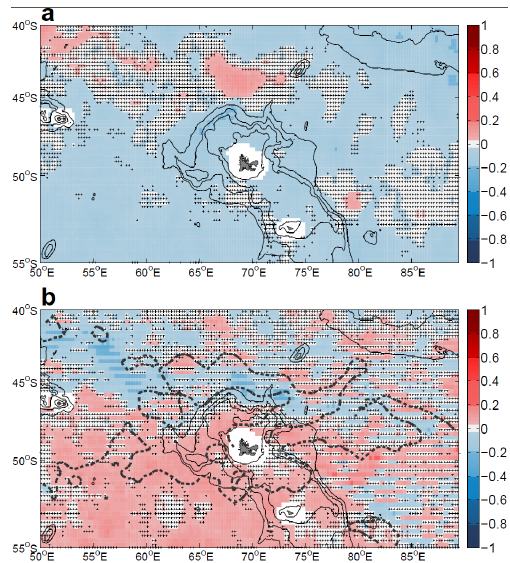
Figure 2. Partial correlation coefficients for unfiltered daily anoma- lies of (a) wind speed vs. SST and (b) wind-stress curl vs. SST, in both cases controlled for NCEP/CFSR surface heat fluxes. Par- tial correlations are computed for the spring and summer grow- ing season only, from September to February. In (a) blues indicate that positive wind anomalies are associated with cold SSTs, and in (b) reds in the region adjacent to Kerguelen indicate that negative wind-stress curl is linked to cold SSTs. Pixels are cross-hatched where the correlation coefficient is not statistically significant at the 95%. Black dashed line indicates the climatological mean zero- wind-stress curl line; negative wind-stress curl occurs south of the zero-wind-stress curl line (and within closed contours to the north) and corresponds to upward vertical Ekman